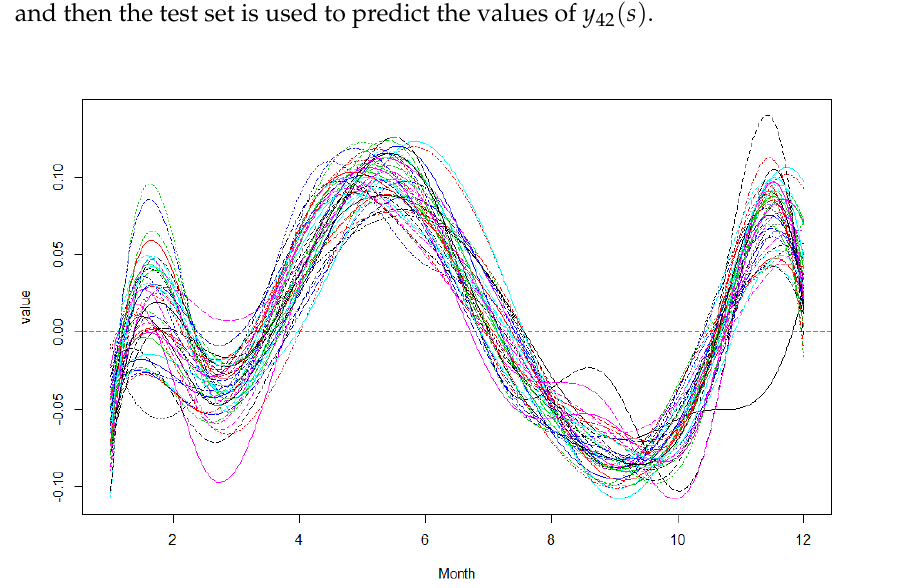
Figure 4. Annual curves of electricity data in the commercial sector from January 1973 to January 2016.